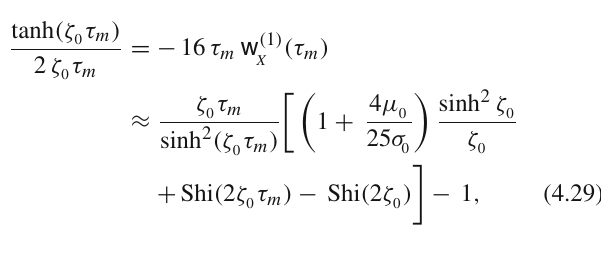
Fig. 1 Variation of the percentage change in the effective DE equa- ) , with a the rationalized cosmic time tion of state: − μ = 100 ( 1 + w X τ = t / t , and b the rationalized correction y = Y / Y in the MMT 0 0 = 0 . 05 and discrete values of potential, for a fixed parametric value σ 0 ∈ ( 0 , 0 . 15 ) . The thick dots indicate the minima of the the parameter μ 0